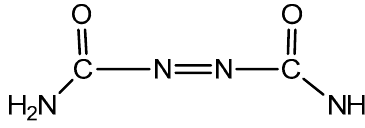
Figure 1. The molecular formula of ADCA.